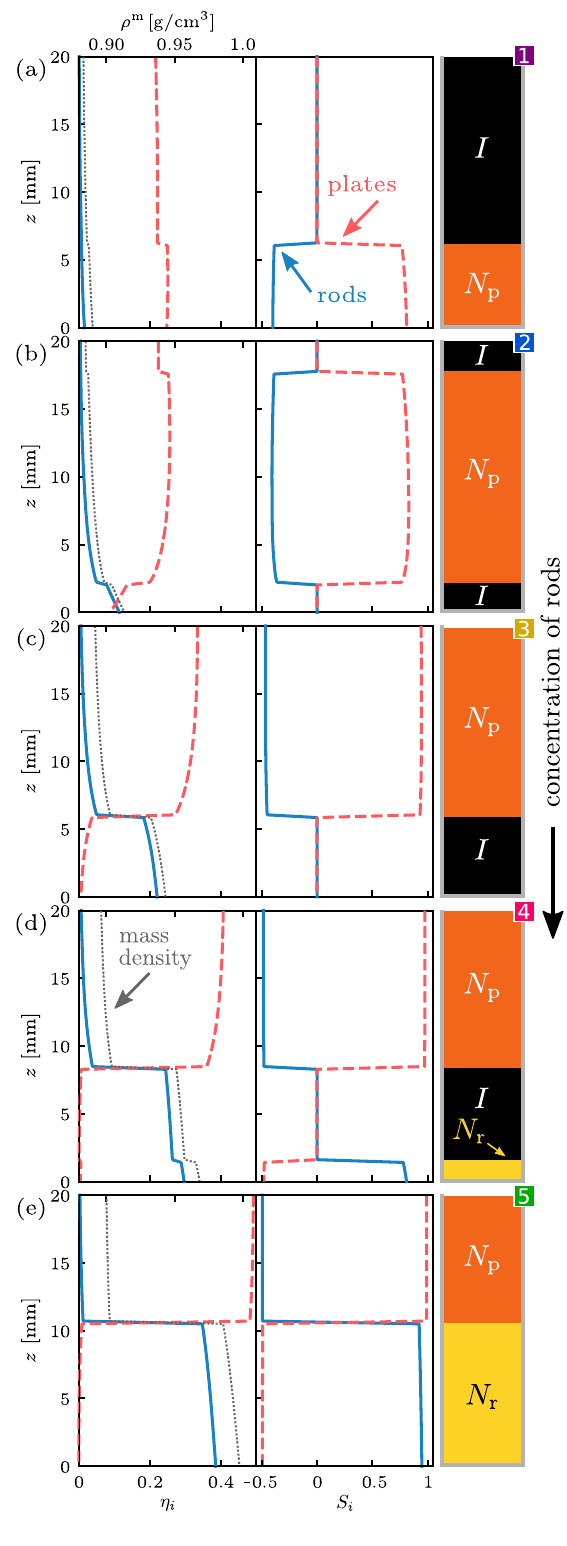
Fig. 7 Changing the concentration of rods. Packing fraction η i ( i = r, p for rods and plates, respectively) and total mass density ρ m pro fi les, uniaxial order parameter S i , i = r, p pro fi les, and schematics as a function of the vertical coordinate z for samples of height h = 20 mm, fi xed concentration of plates (cid:1) η ¼ 0 : 23 and varying concentration of rods (cid:1) η ¼ 0 : 006 ( a ), p r 0.025 ( b ), 0.075 ( c ), 0.12 ( d ), and 0.20 ( e ). The slope of the sedimentation path is s = 0.5. The corresponding sedimentation paths are depicted in Fig. 6b. The samples are also marked in the stacking diagrams of Fig. 6c, d using the same labels as here (colored squares with a number from 1